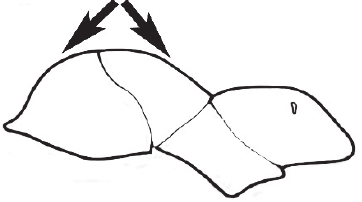
triangle narrowly semi-oval (some workers of M . griseus ); in profile, pronotum and mesonotum may form a strong convexity; frons of major worker (only known for Melophorus gibbosus ) uniformly distinctly microreticulate ........ 23